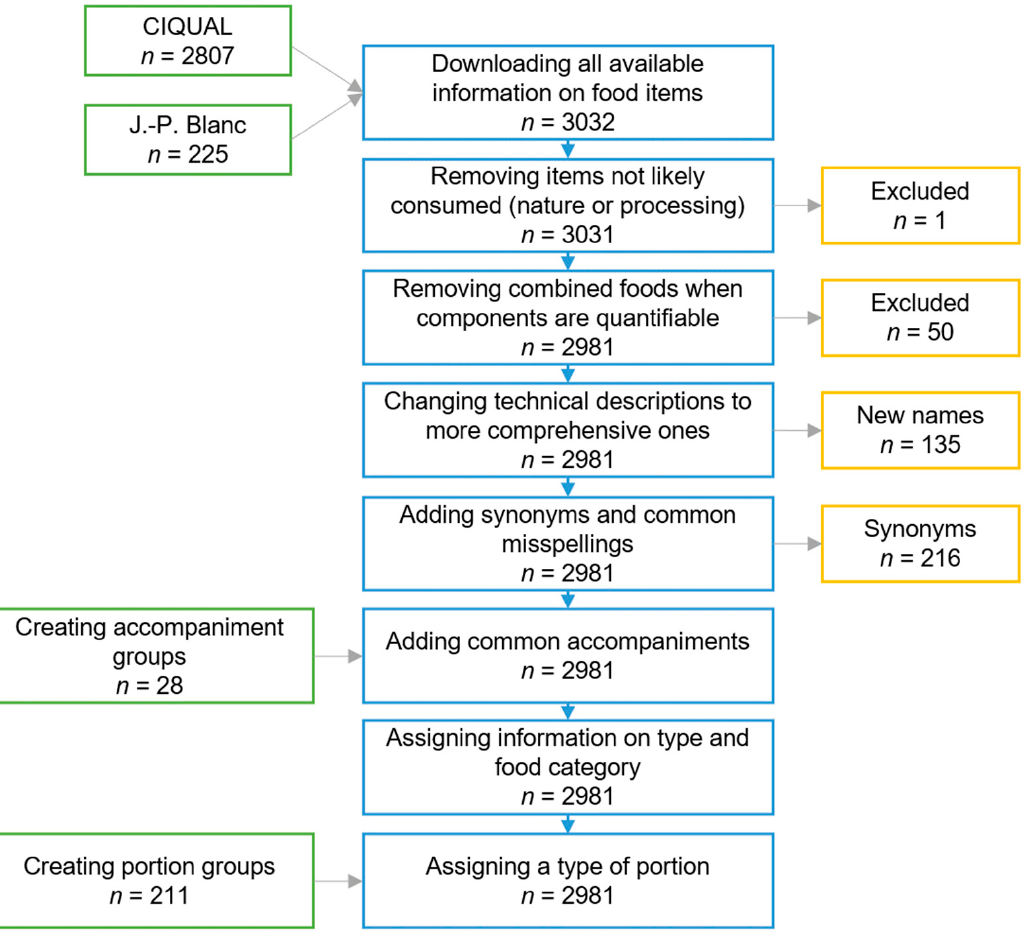
Figure 2. Database’s overall development methodology.